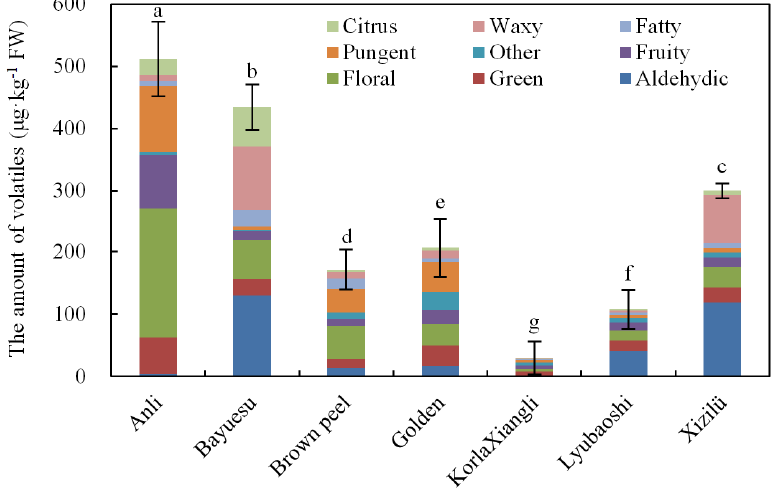
Figure 3. The concentrations of different odor types in the flowers of seven pear cultivars.